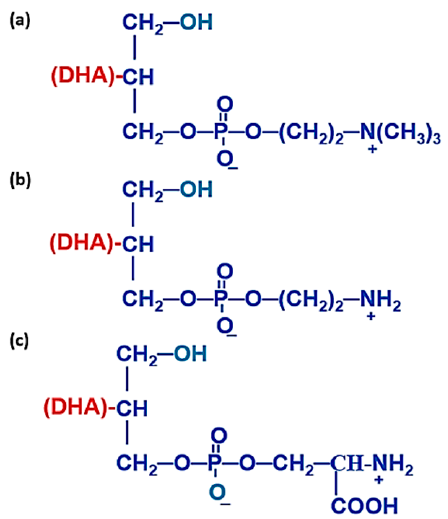
Figure 9. Chemical representation of some lysophospholipids with DHA moiety at sn-2 position. ( a ) Chemical representation of some lysophospholipids with DHA moiety at sn-2 1-lyso,2-docosahexaenoyl, glycerophosphocholine (Lyso-PC-DHA), ( b ) 1-lyso,2-docosahex- aenoyl,glycerophosphatidylethanolamine (Lyso-PE-DHA), ( c ) 1-lyso,2-docosahexaenoyl, glycer- ophosphatidylserine (Lyso-PS-DHA).